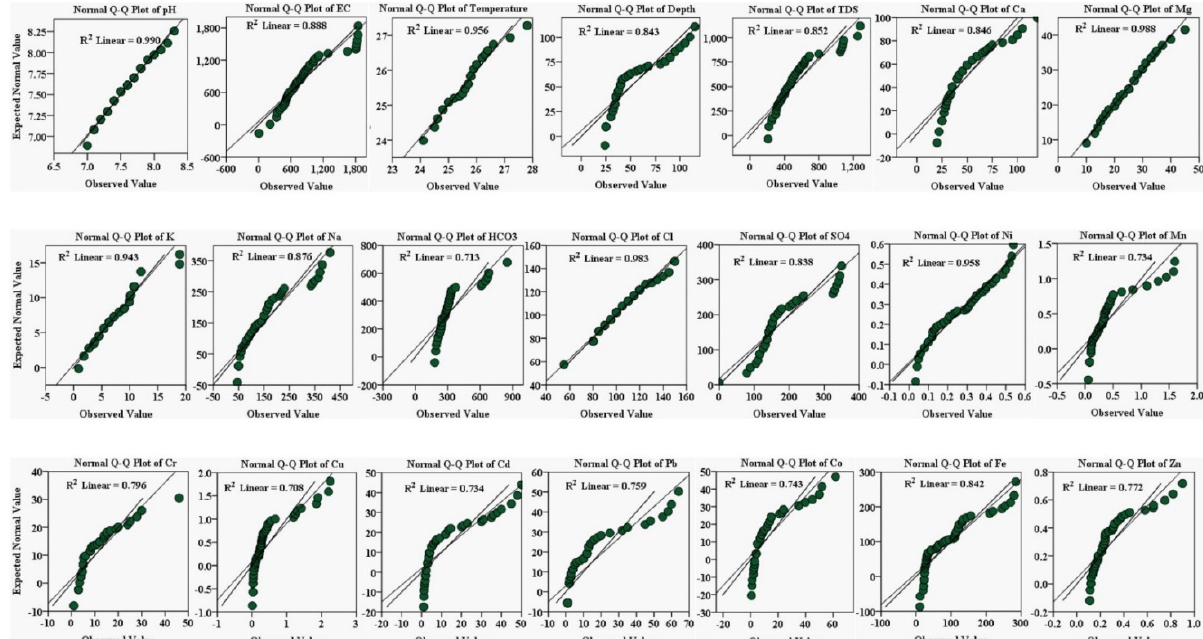
Figure 6. Describe the normal Q-Q box plot of physicochemical variables, viz., pH, EC, temperature, depth, Ca, Mg, K, Na, HCO 3 , Cl, SO 4 , and the PHEs, viz., Ni, Mn, Cr, Cu, Cd, Pb, Co, Fe, and Zn, in the groundwater of the Adenzai flood plain region, Pakistan.